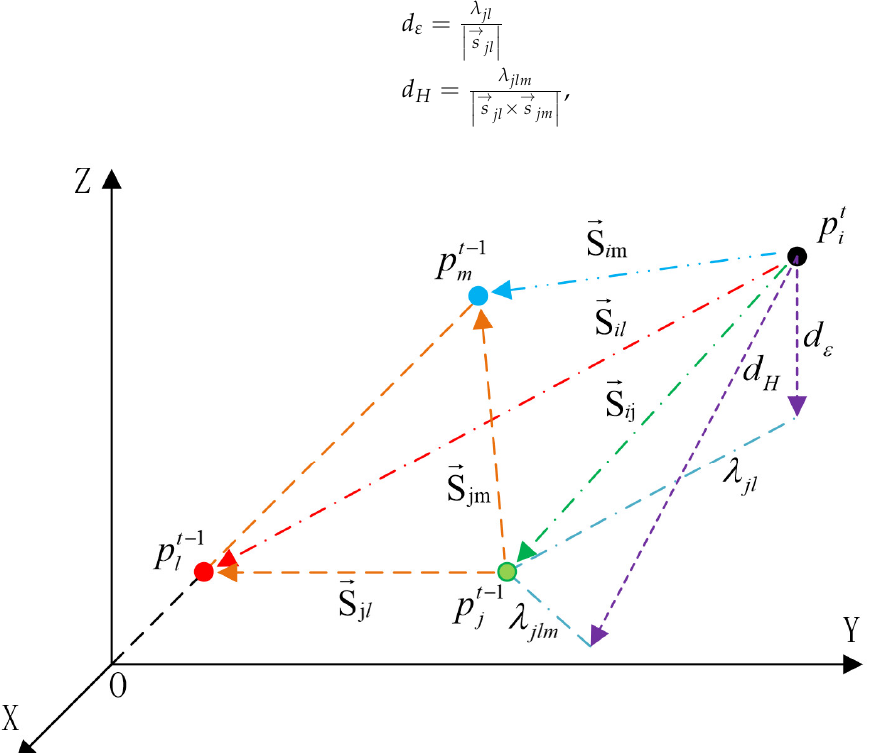
Figure 9. Principle of eigenvector solving based on area method. The smaller the values of d ε and d H , the shorter the distance between the current frame feature point p t and the previous frame surface feature F t − 1 i cloud F t − 1 , as shown in Figure 10. When point p t e feature F t − 1